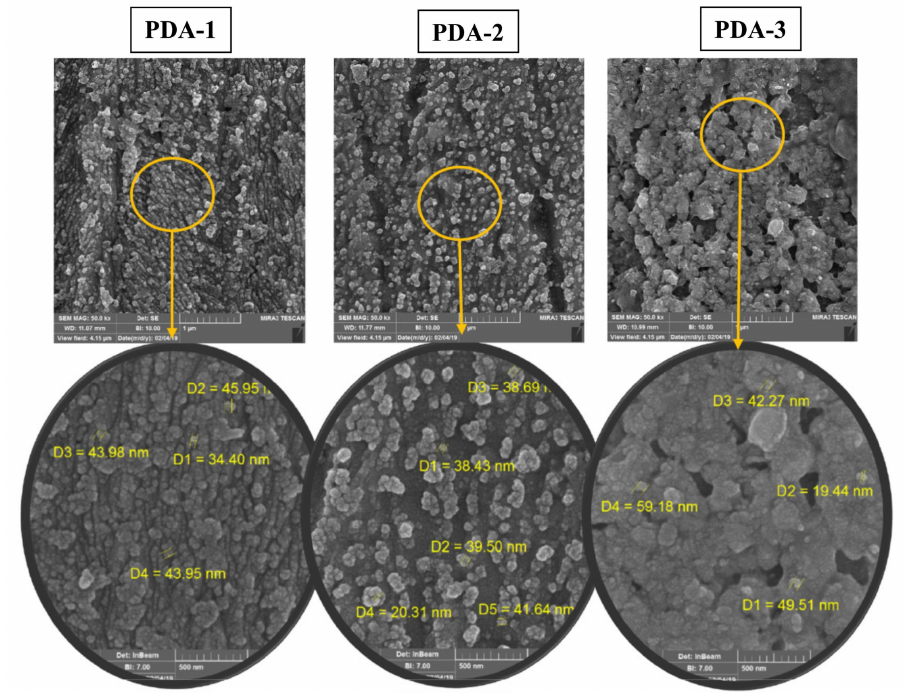
Figure 15. SEM images of mild steel surfaces after 24 h immersion in 1.0 M HCl solution in the presence of PDA-1, PDA-2, and PDA-3. (Reprinted with permission from Ref. [239]. Copyright 2020 Elsevier